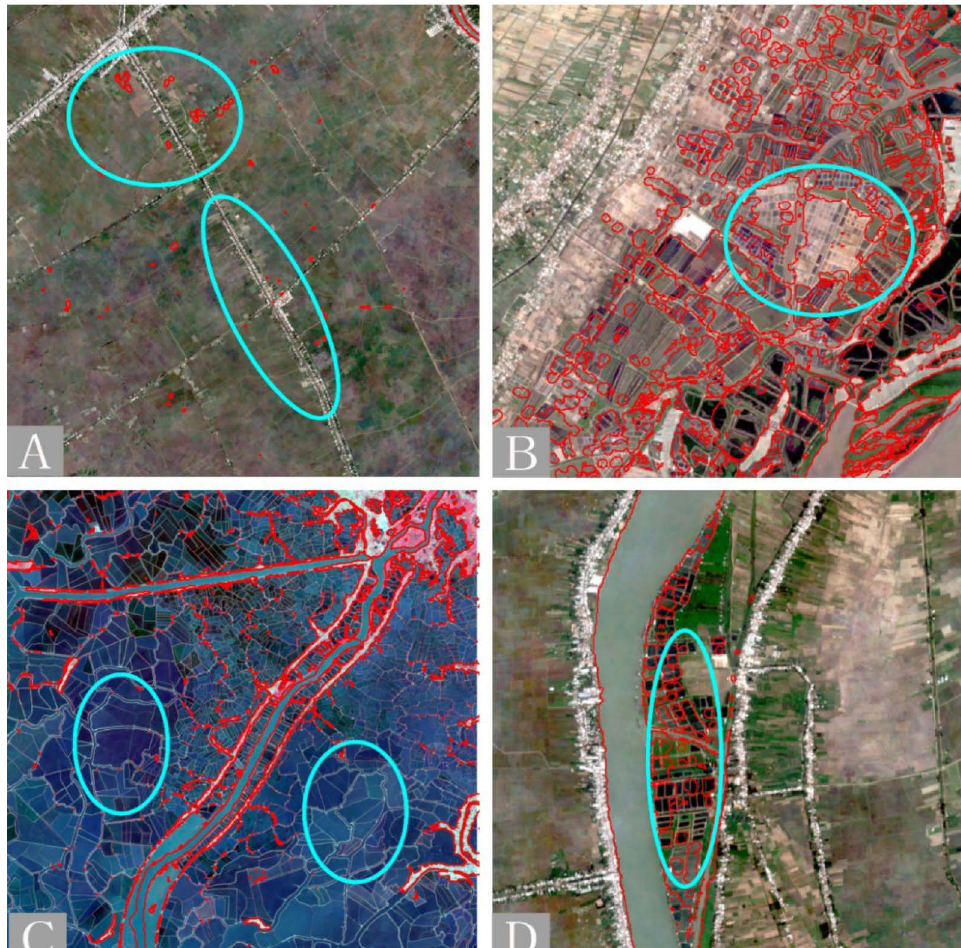
Figure 7. Automatic mapping errors: ( A , B ) are examples of misclassification as roads and bare land. ( C , D ) are embankments misclassification in aquaculture